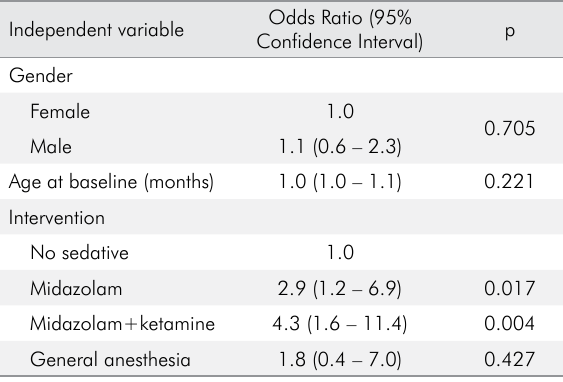
Table 2. Cox regression model for independent variables explaining quiet behavior (OSUBRS score = 1; scores assessed at 5 intervals during follow-up dental exams).